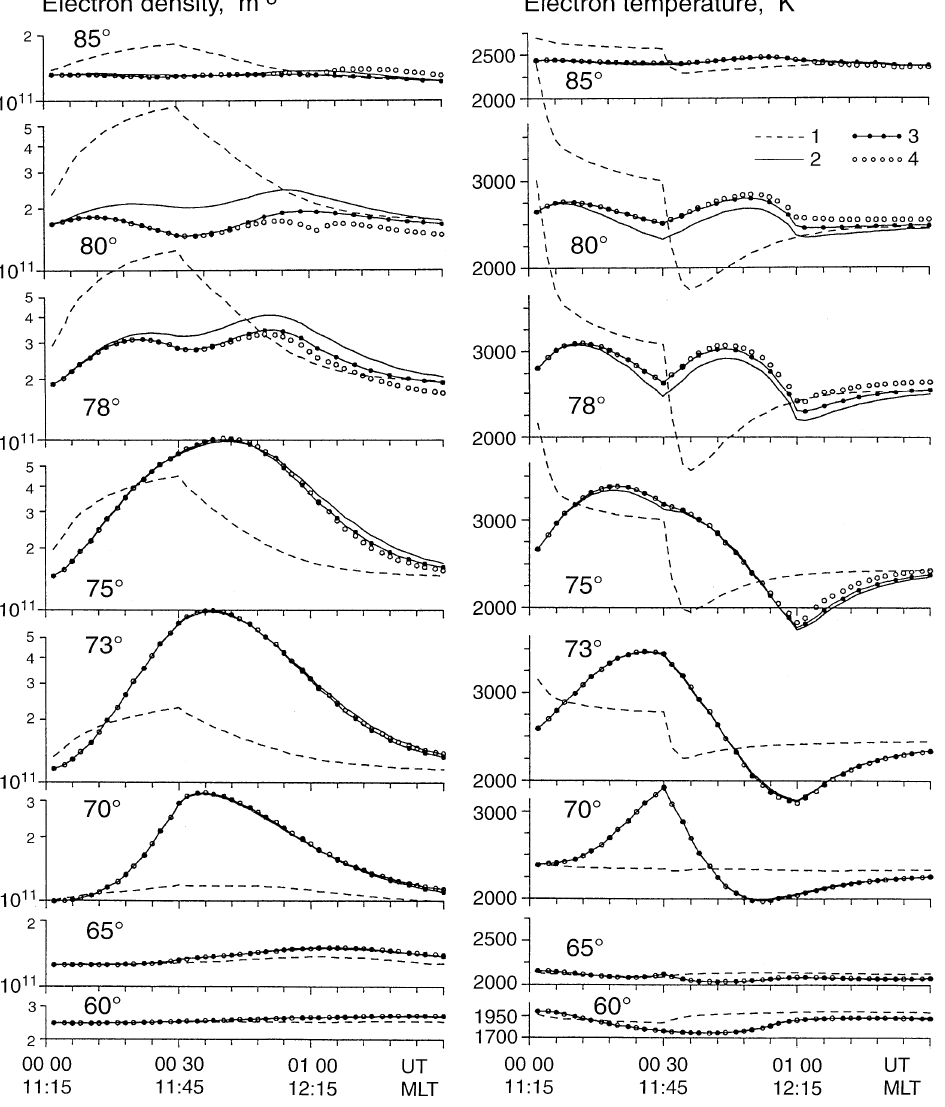
Fig. 5. Time variations of the calculated electron concentra- tion ( left - hand plots ) and elec- tron temperature ( right - hand plots ) at h " 300 km, (cid:75) " 240 ° , at various geomag- netic latitudes for variants 1 ( dashed curves ), 2 ( solid curves ), 3 ( black - circle curves ) and 4 ( open circles ) of the calculations (see text for ex-